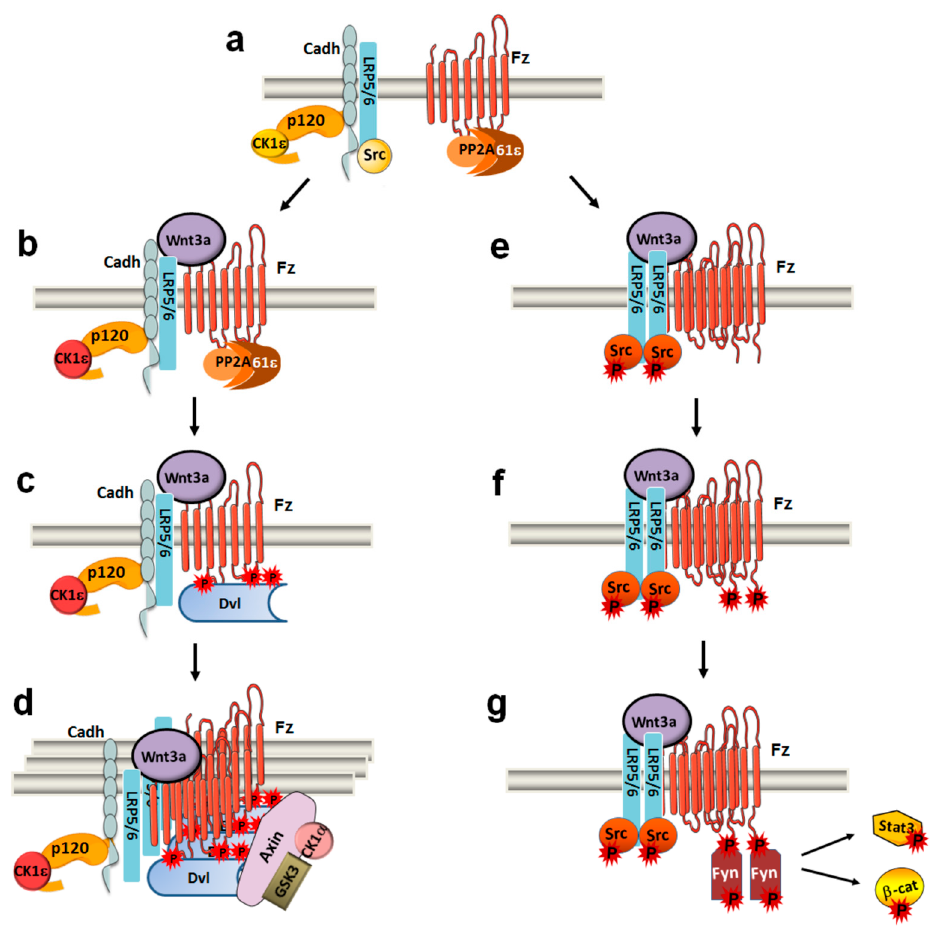
Figure 1. Canonical Wnt ligands induce two mutually exclusive Dvl2- and Fyn-dependent arms. ( a ) In Wnt OFF, LRP5/6 co-receptor interacts through p120-catenin and E-cadherin with inactive CK1 ε and Src (both inactive kinases are shown in yellow). ( b ) Wnt3a promotes that PP2A phosphatase, associated to Fz2 through the PR61 ε regulatory subunit, moves closer to CK1 ε , and dephosphorylates and activates CK1 ε (in orange). ( c ) CK1 ε increases Dvl2 phosphorylation and its binding to Fz2. ( d ) Dvl2 ′ s association leads to signalosome assembly, axin recruitment, and further responses of this pathway. ( e ) LRP5/6 dimerization promotes Src activation and ( f ) Src-dependent phosphorylation of Tyr552 in Fz2. ( g ) Phospho-Tyr552 binds and activates Fyn, promoting the phosphorylation of Stat3. Fyn also phosphorylates β -catenin Tyr142, releasing β -catenin from α -catenin and cadherin and thereby facilitating its transcriptional activity.